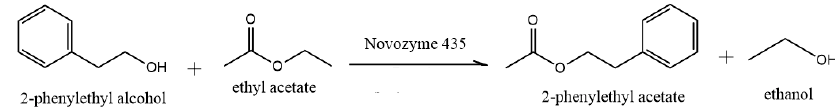
Figure1. The reaction diagramof 2-phenylethyl acetate(2-PEAc) synthesiscatalyzed by Novozym ® 435. Catalysts 2020 , 10 , x FOR PEER REVIEW Figure 1. The reaction diagram of 2-phenylethyl acetate (2-PEAc) synthesis catalyzed by Novozym ® 435.